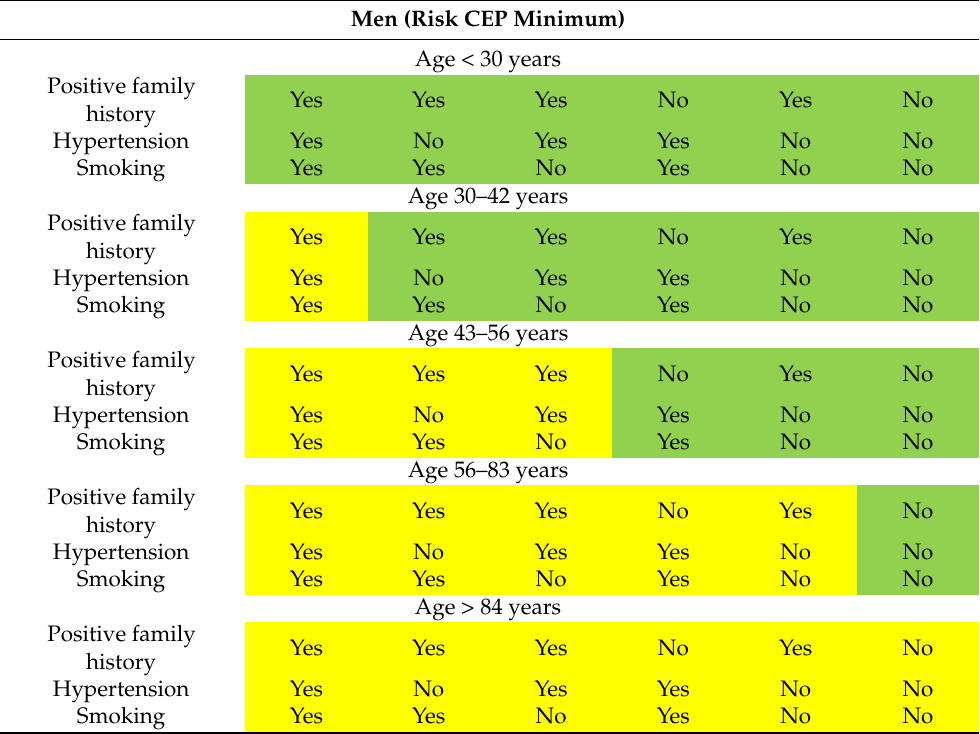
Green background—low probability of CEP development (CEP development is not